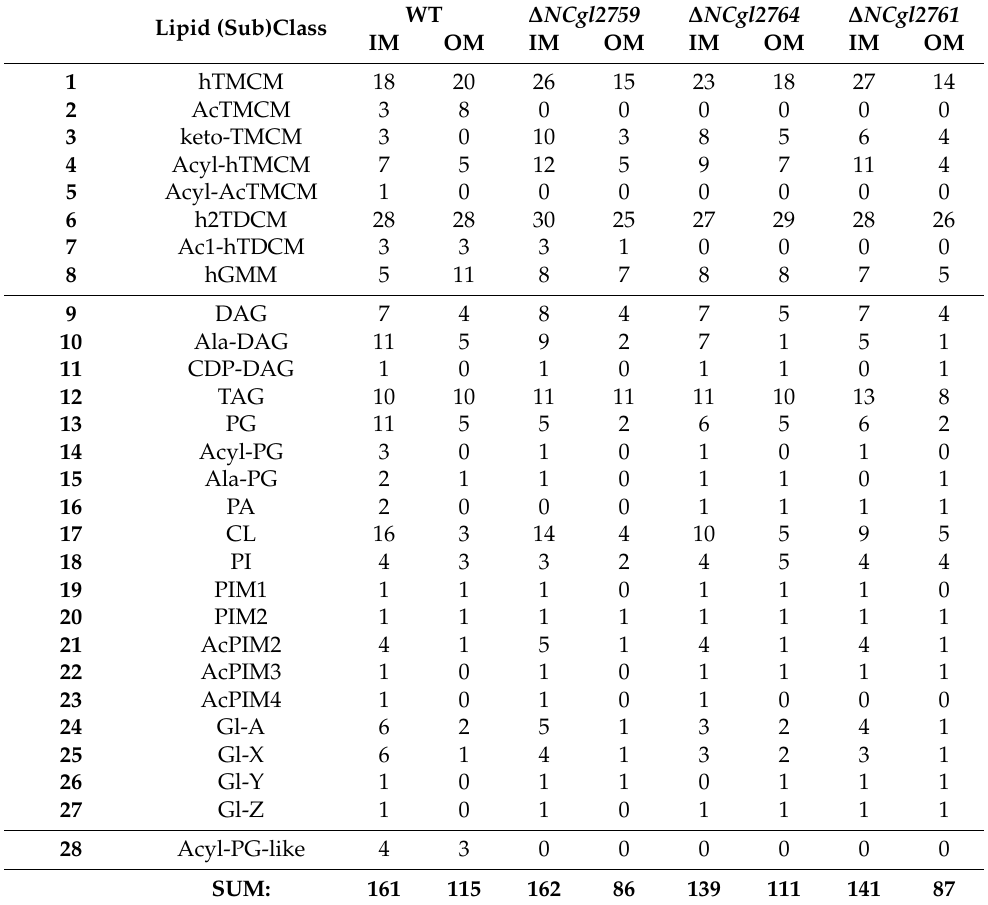
Table 1. Detected lipid (sub)classes and lipid species of the IM and OM fraction of the C. glutamicum WT, ∆ tmaT ( ∆ NCgl2759 ), ∆ mtrP ( ∆ NCgl2764 ) and ∆ mmpA ( ∆ NCgl2761 ) mutants via LC-MS/MS ESI TOF in positive ionization mode